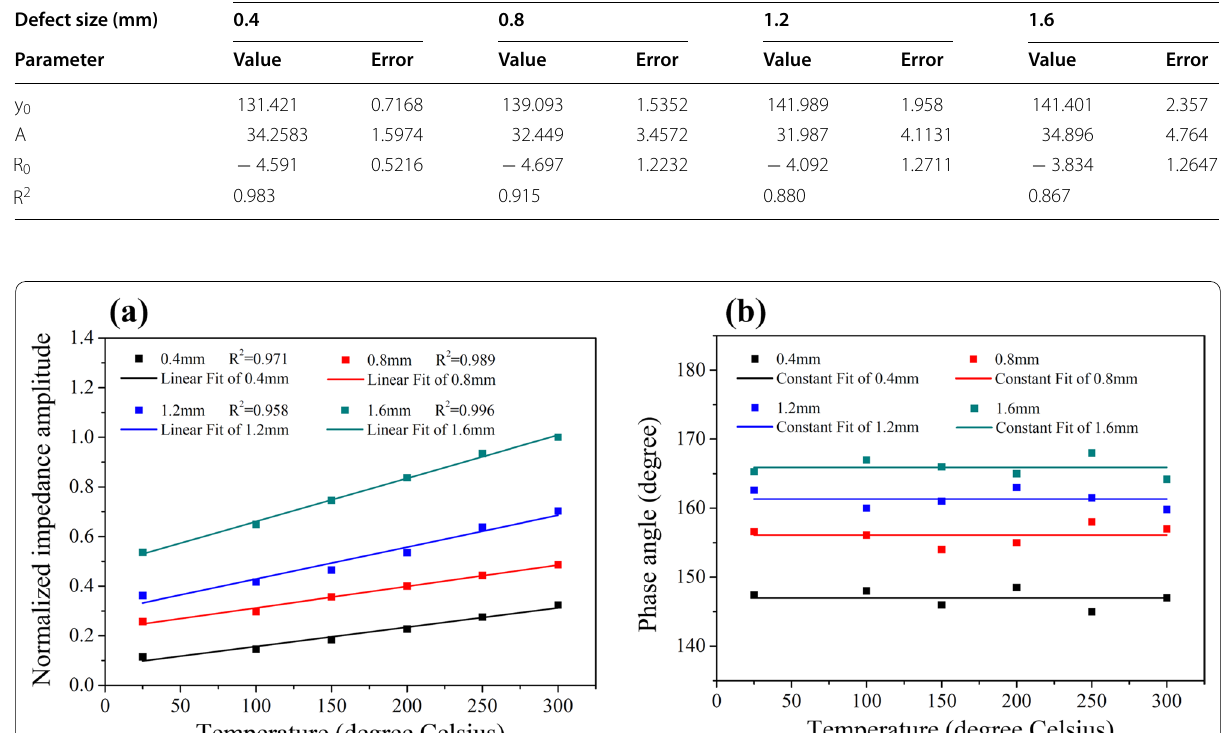
Table 4 Coefficients and correlation coefficients of fitting curves in Figure 10(b) Equation